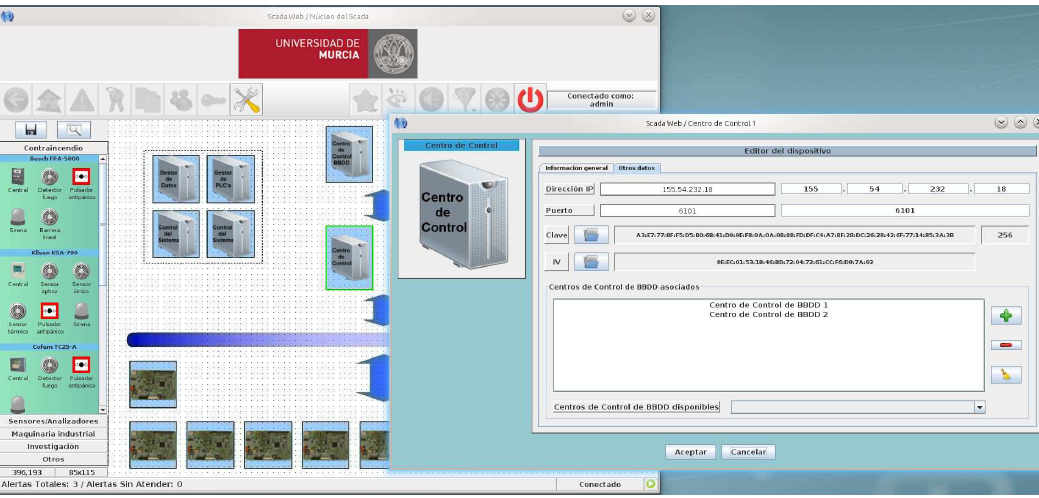
Figure 10. Screenshot of the HAM set-up